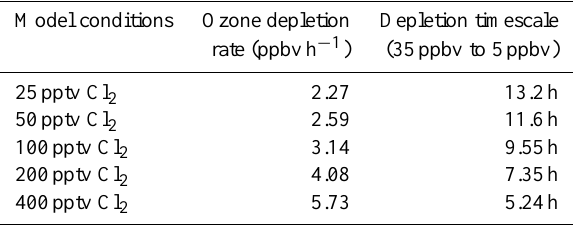
Table 9. Ozone depletion rates in ppbvh − 1 calculated by Eq. (3) and the corresponding timescale for ozone depletion from 35 to 5ppbv for mid-day of 29 March for five different modeling sce- narios performed by varying Cl 2 mole